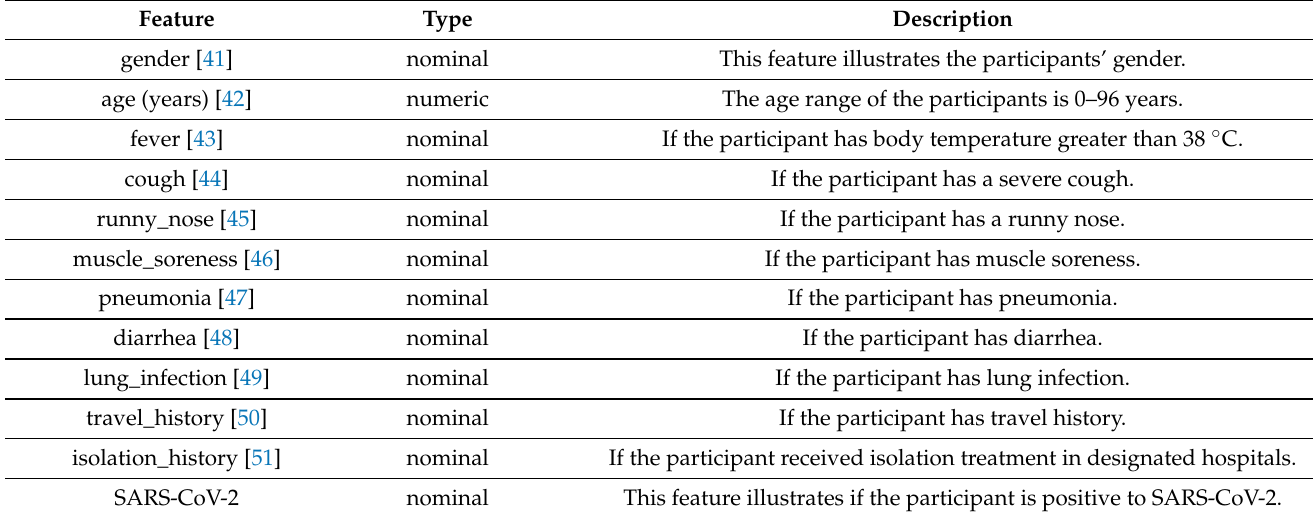
Table 1. Dataset